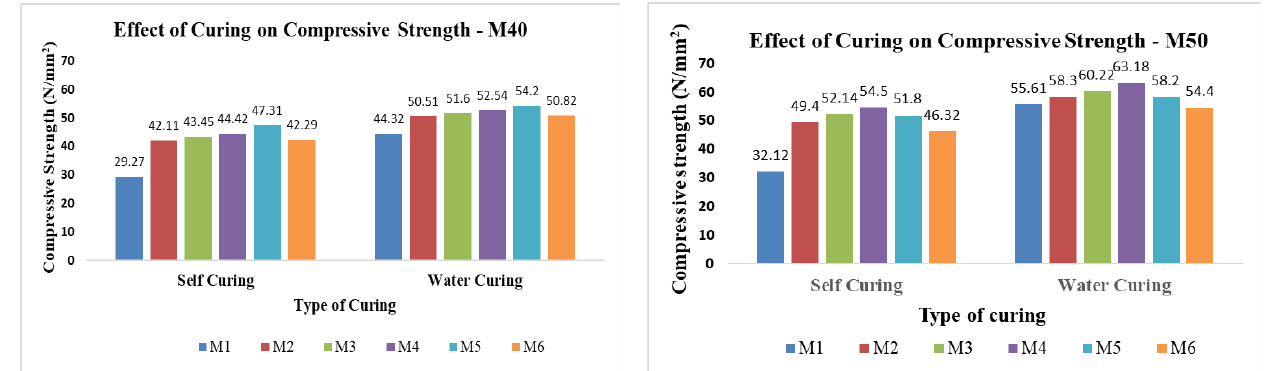
Figure 1. Impact of curing on compressive strength of concrete.